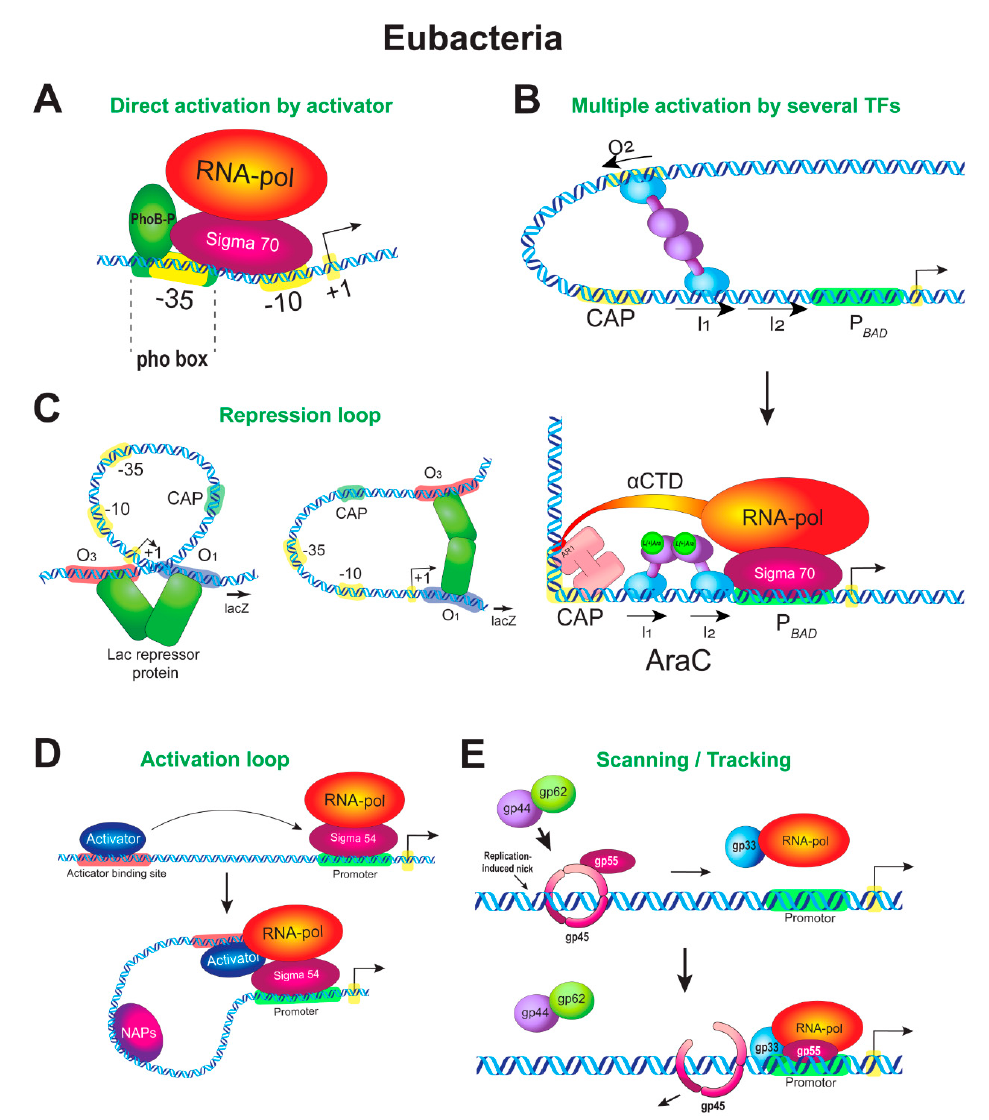
Figure 1. Enhancer-like mechanisms of transcription regulation in prokaryotes. ( A ) Stimulation of RNAP by an adjacent activator. Pho-regulon genes are responsible for adaptation of bacteria to phosphorus starvation. Expression of the Pho-regulon genes is regulated by a two-component system through direct contact of an activator PhoB with the RNAP– σ 70 complex. Lack of phosphorus in the medium leads to phosphorylation of PhoB (PhoB-P), which then acts as an intracellular soluble response regulator. PhoB-P as a dimer binds to its binding sites at the promoters of Pho-regulon genes (pho-boxes), thus compensating for the weak − 35 element, and recruits the RNAP– σ 70 complex to the promoters. The physical interaction of PhoB-P with σ 70 in the region of the − 35 element is shown. ( B ) Multiple activation of RNAP by several activators. Regulation of the araBAD promoter is shown. The upper panel illustrates the repression state in which the promoter is repressed by the AraC regulator. The lower panel shows the transition from repression to activation, which occurs by changing the conformation of the promoter DNA. The repression loop is broken by the CAP protein; the promoter is bent by CAP and the site of AraC binding is switched. Changing the promoter DNA conformation allows the activators to interact with RNAP. ( C ) Repression loop. Two alternative conformations of the lac operon promoter are shown. The lac-operon is regulated by a one-component regulatory